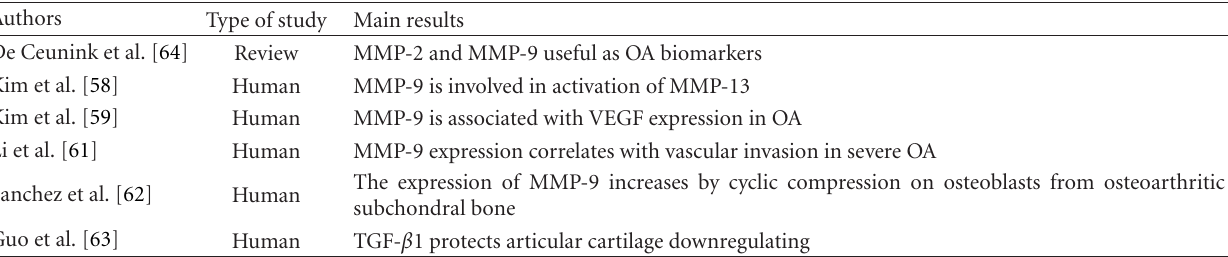
Table 2: Articles dealing with the gelatinases over the last